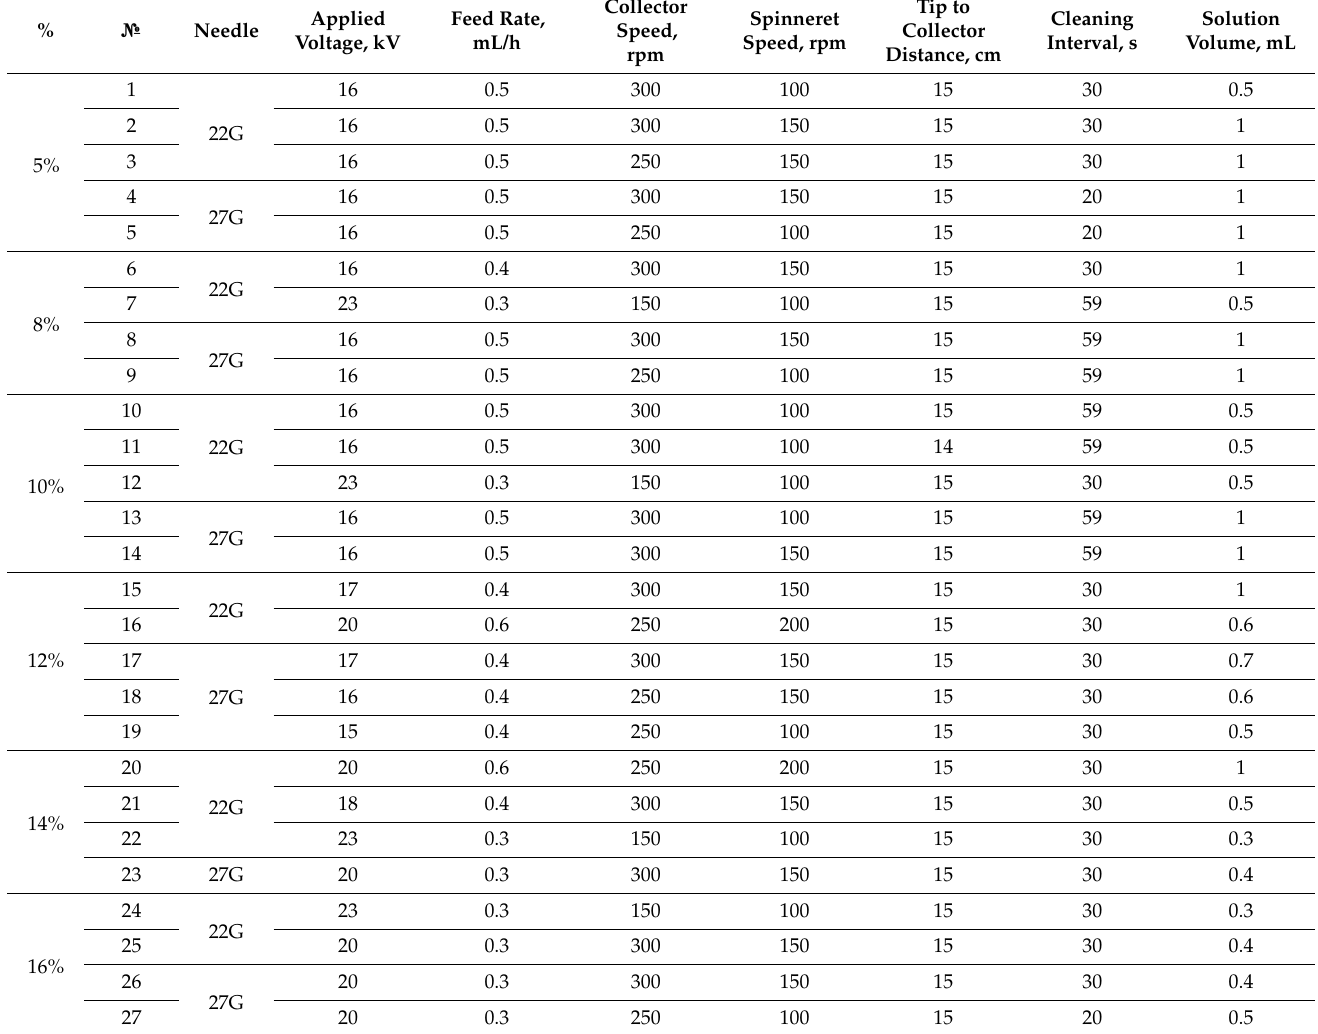
Table 1. Electrospinning setup parameters, by polymer solution